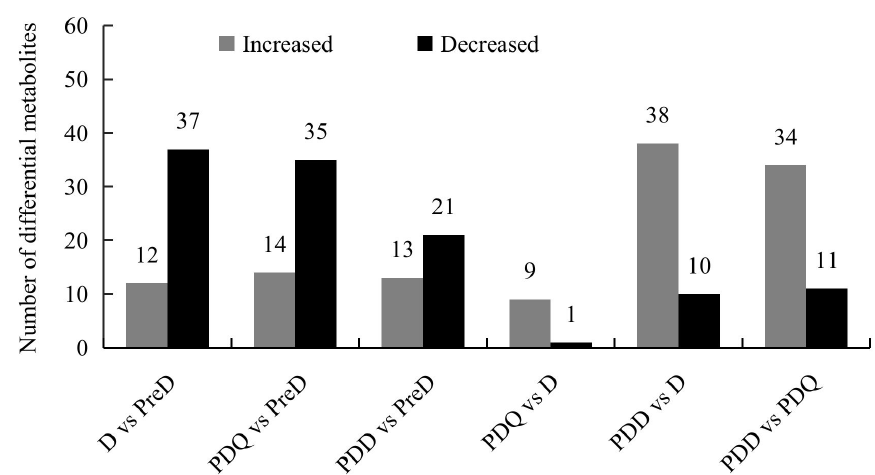
Figure 3. Number of differential metabolites of pairwise comparisons between pre-diapause (PreD), diapause (D), post-diapause quiescence (PDQ) and post-diapause developmental larvae (PDD) of Sitodiplosis mosellana .